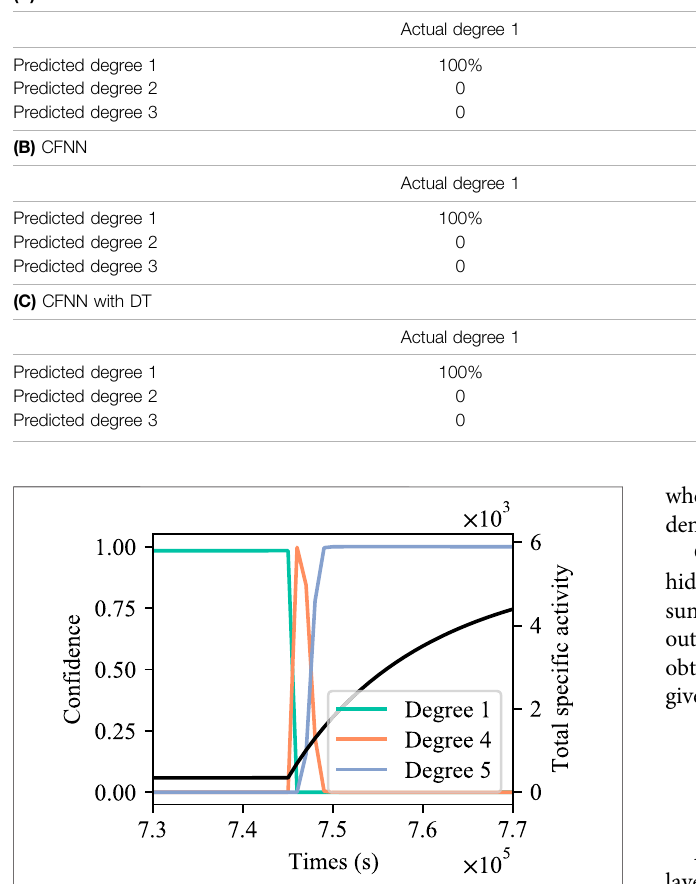
FIGURE 6 | Variation of total speci fi c activity and neural network output after fuel failure of degree